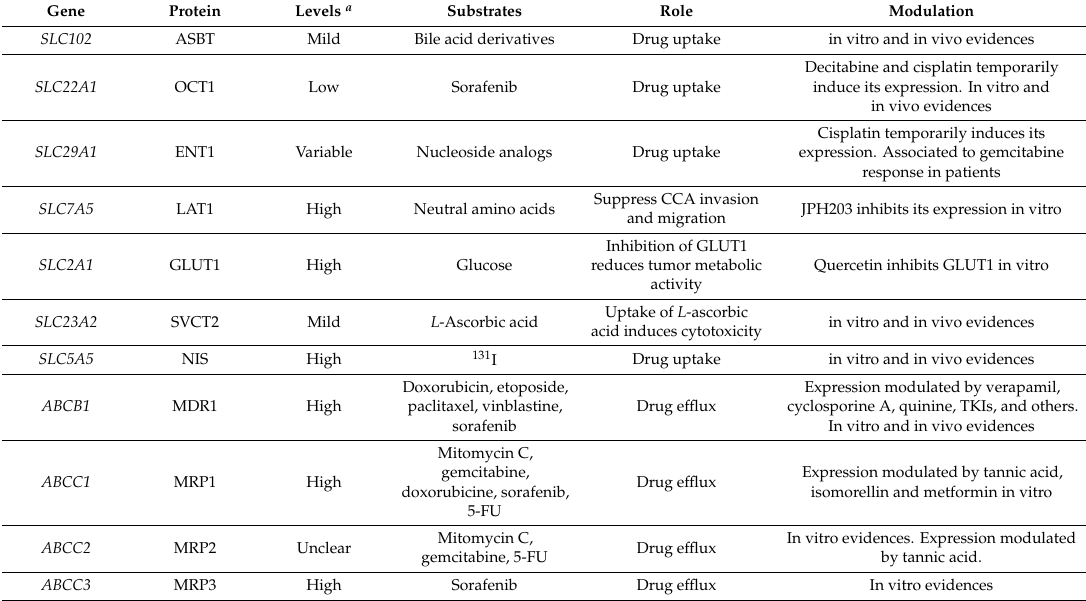
Table 2. Plasma membrane transporters with potential usefulness as targets in